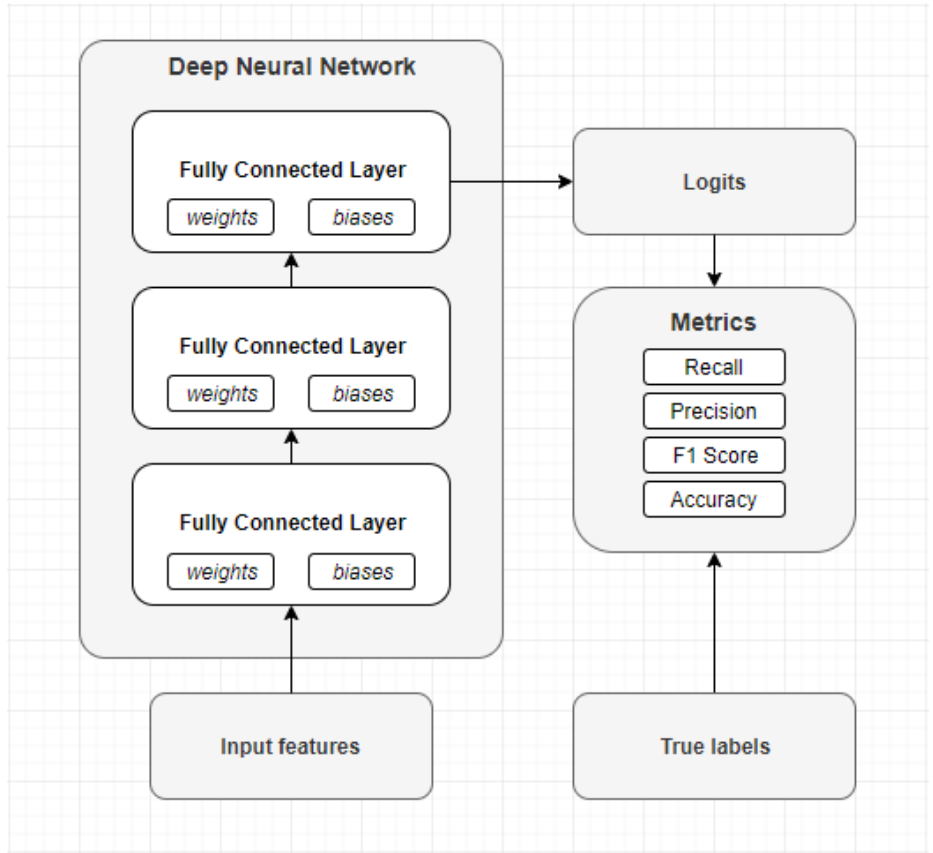
Figure 5. Structure of the Deep Neural Network